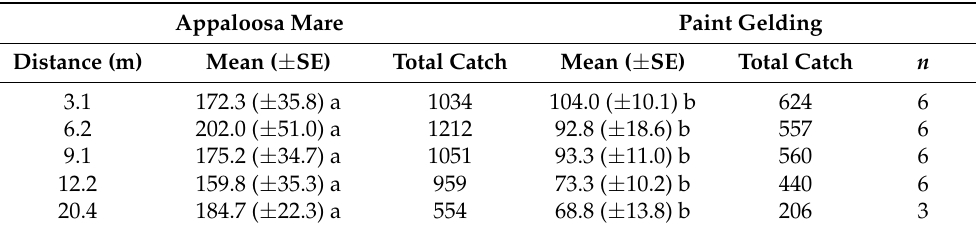
Table 6. Mean ( ± SE) and total number of mosquitoes vacuumed from each horse when one horse is separated from the other horse by the designated distance; 4–22 October 2004 study, UF Horse Teaching Unit, Gainesville, FL, USA. Appaloosa Mare Paint Gelding Distance